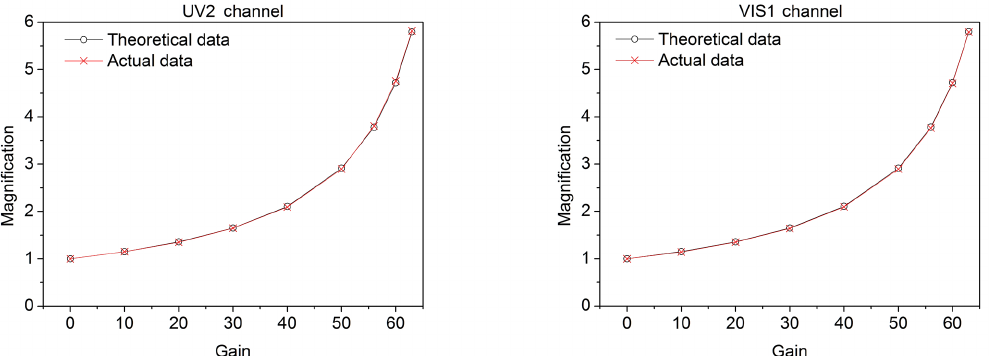
Figure 11. Relation between gain steps and gain value are presented. The relative deviation between theoretical and actual data is less than 1.0%. In application, the gain value can be obtained from the theoretical